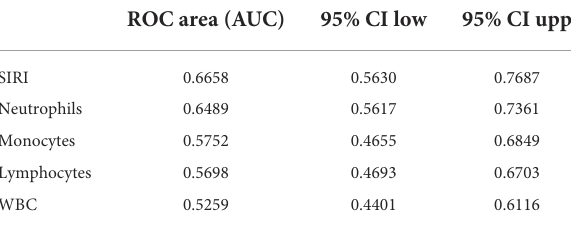
TABLE 5 Receiver operating curve (ROC) for prediction for 30-day mortality in TBI Patients before PSM. ROC area (AUC) 95% CI low 95% CI upp